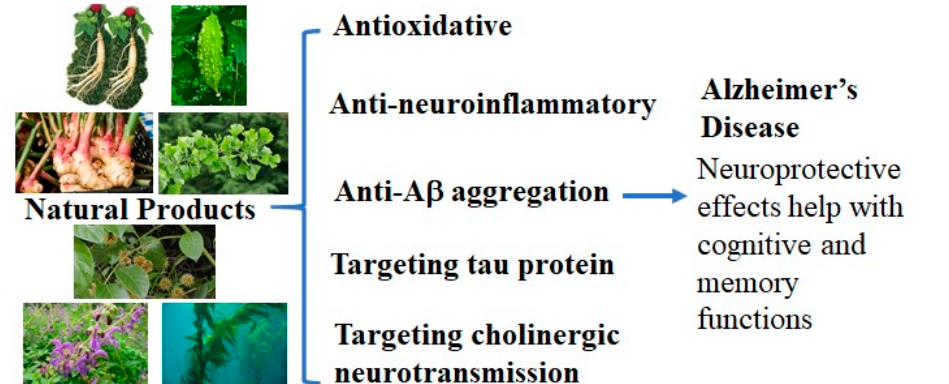
Figure 1. Neuroprotective effects from natural products for AD.